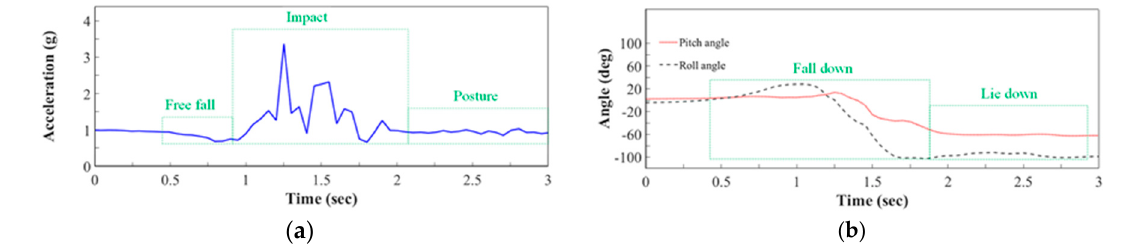
Figure 2. ( a ) Root Mean Square (RMS) acceleration during falling movement; ( b ) Pitch and roll. angles during falling